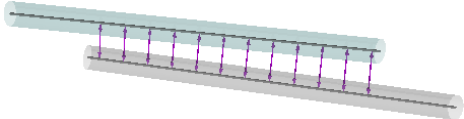
Figure 3: Distance profile for a pair of